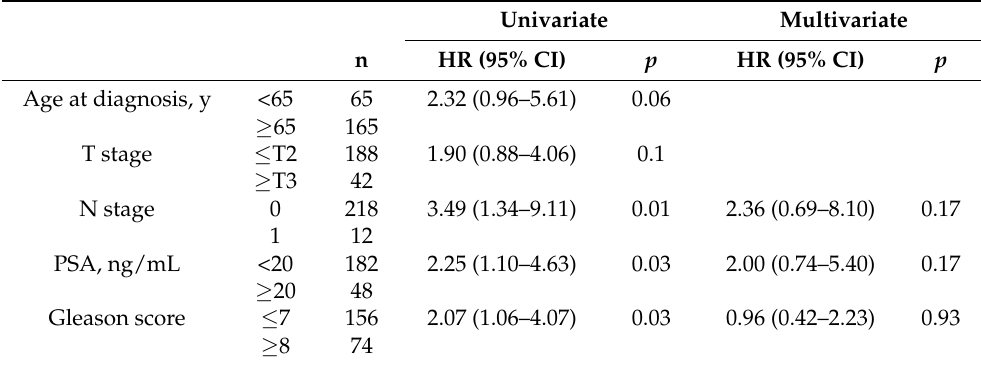
Table 2. Univariate and multivariate analyses of